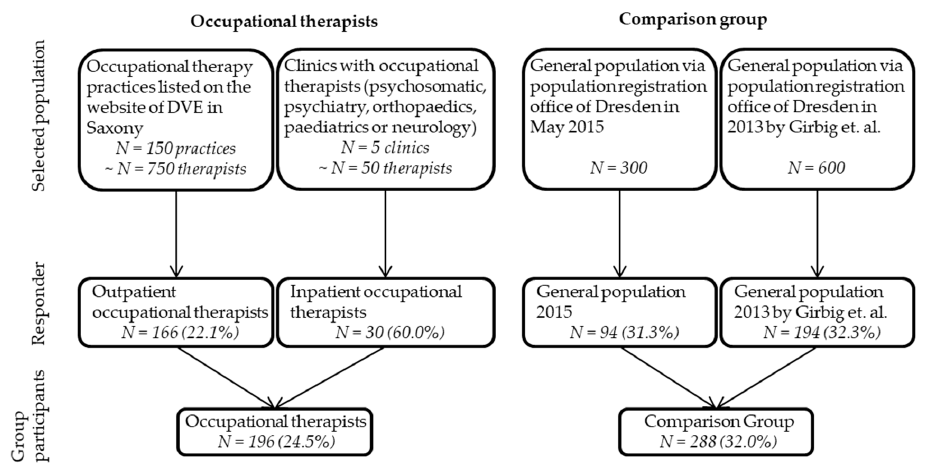
Figure 1. Recruitment process and response.